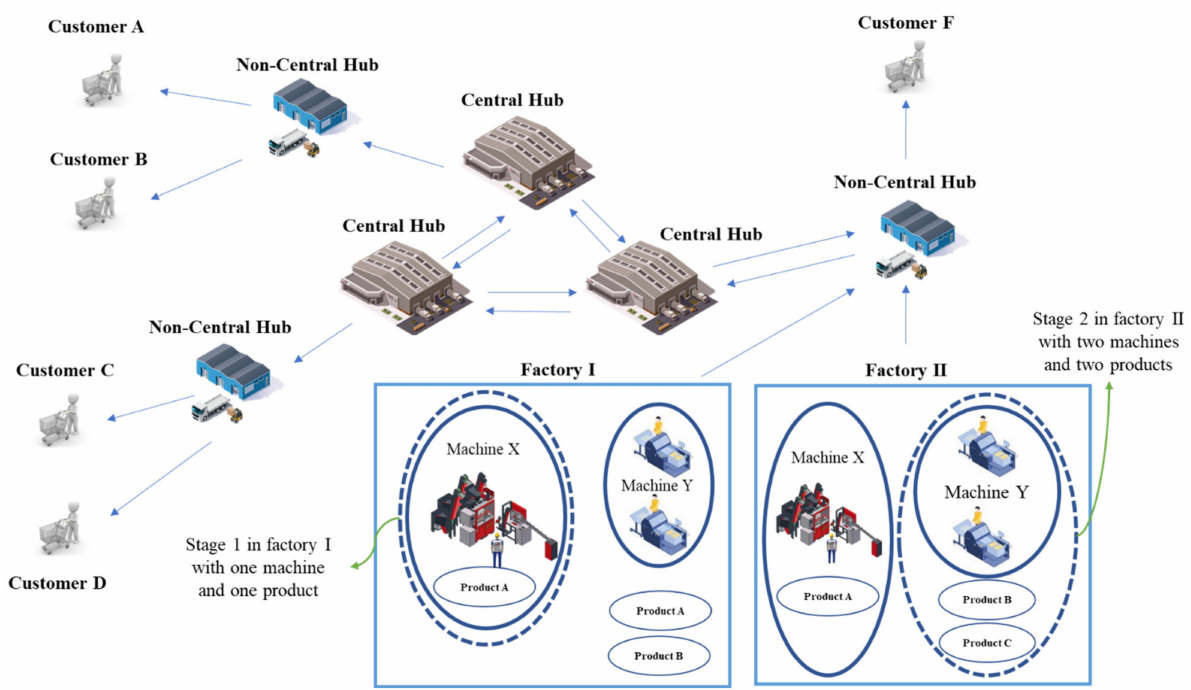
Figure 1. The structure of the model. There are two kinds of objective functions in this research (i.e., λ 1 and λ 2 ). The first consists of transportation and production costs. Indeed, part (a) calculates products’ send‑ ing costs from non‑central hub j (NCHF) to central hub k (CH), then from central hub k to ′ ′ another central hub k , and, finally, from central hub k to non‑central hub h (NCHC). The next part, part (b), calculates products’ sending costs from non‑central hub j to central hub k, then from central hub k to non‑center hub h. Part (c) calculates the cost of connecting customer c to non‑central hub h. Part (g) calculates the production cost of product p in factory f. The cost of connecting non‑central hub h to central hub k is calculated in part (d). Part (e) calculates the cost of connecting factory f to non‑central hub j. Finally, the cost of connecting non‑central hub j to central hub k is calculated in Part (f).